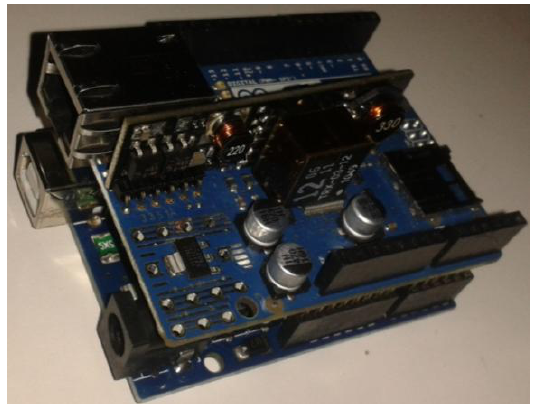
Figure 1. Arduino UNO and Ethernet